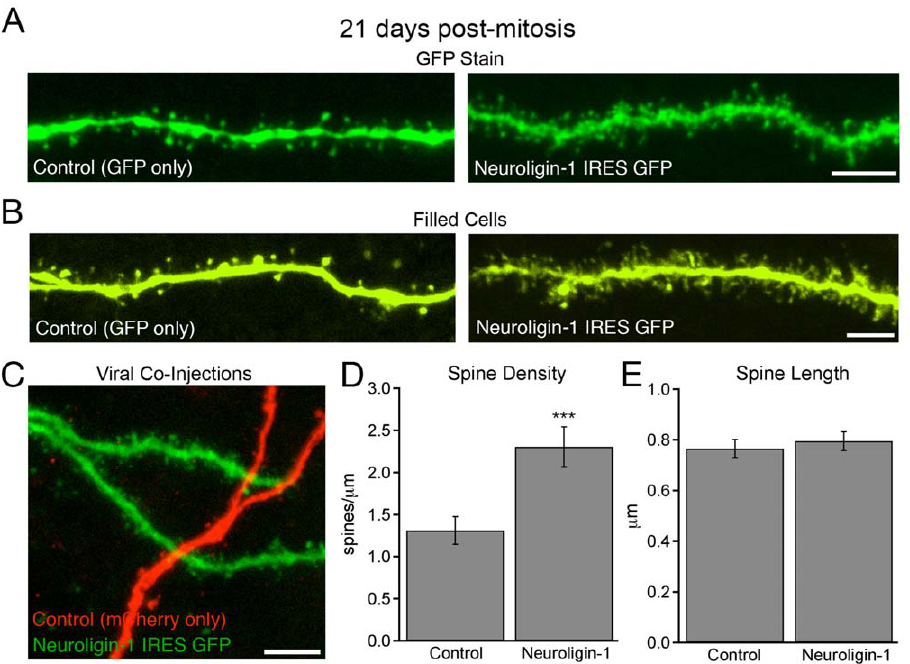
Figure 2. Neuroligin-1 overexpression increases dendritic spine number. A. Dendritic spine morphology as demonstrated from GFP expression in 21-day-old granule cells expressing GFP only (control) or HA-neuroligin-1 in conjunction with GFP. Scale bar: 5 m m. B. To control for variability between fluorophore expression levels, a subset of 21-day-old live cells was identified by GFP expression, filled with membrane- impermeant dye by patch pipette, and fixed. Images show sections of dendrite taken from 21-day-old control cells and neuroligin-1 overexpressing cells. Scale bar: 5 m m. C. The dentate middle molecular layer of an adult mouse co-injected with separate retroviruses expressing mCherry (control) or neuroligin-1 IRES GFP. The projected image shows a 21-day-old control granule cell (mCherry) next to a GFP-filled cell overexpressing neuroligin-1. Scale bar: 5 m m. D, E. Summary data of spine measurements from infected cells 21 days post-mitosis demonstrating an increase in spine density but no change in spine length. Control neurons were infected with a retrovirus expressing GFP only (data shown 6 SEM; control, n=11 cells; NLG-1, n=10 cells; ***p , 0.005).